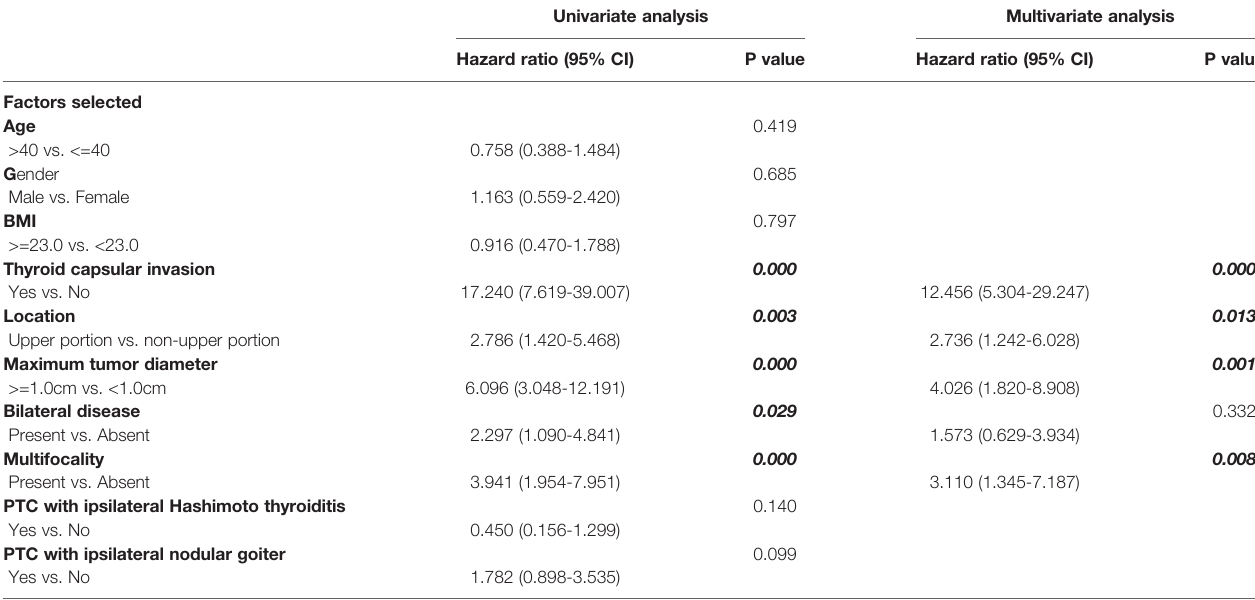
TABLE 4 | Univariate and multivariate logistic analyses of skip LNM for PTC patients with no CLNM.